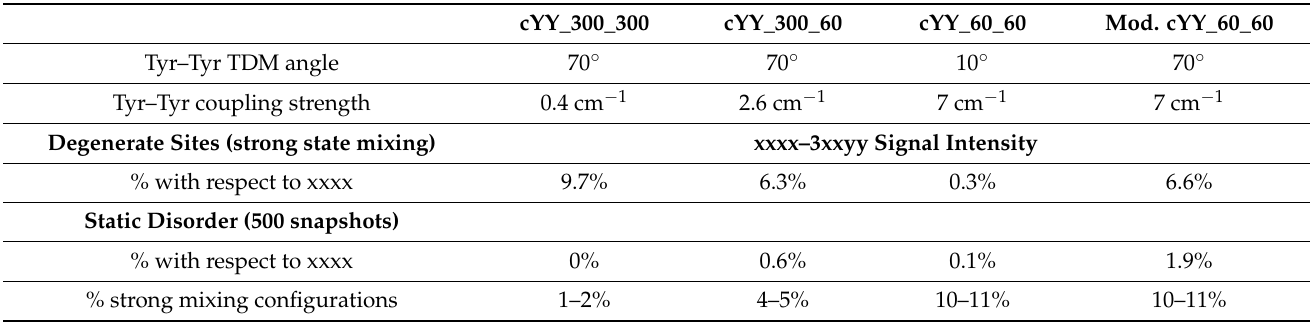
Table 2. Analysis of 2DUV data reported in Figure 3 for the three systems cYY_300_300, cYY_300_60, and cYY_60_60. A modified cYY_60_60 (labeled Mod. cYY_60_60) was also considered, in which the transition dipole moments (TDMs) of the Tyr residues were forced to have a 70 ◦ angle between them. xxxx–3xxyy signal intensities smaller than 0.1% have been set to zero. The reported coupling strength is the Franck–Condon weighted electronic coupling between the L b (u 0 ) Tyr vibronic transitions. Strong mixing is defined as follows: the exciton wave functions must have coefficients between 0.71/ ± 0.71 (perfect exciton) and 0.90/ ±